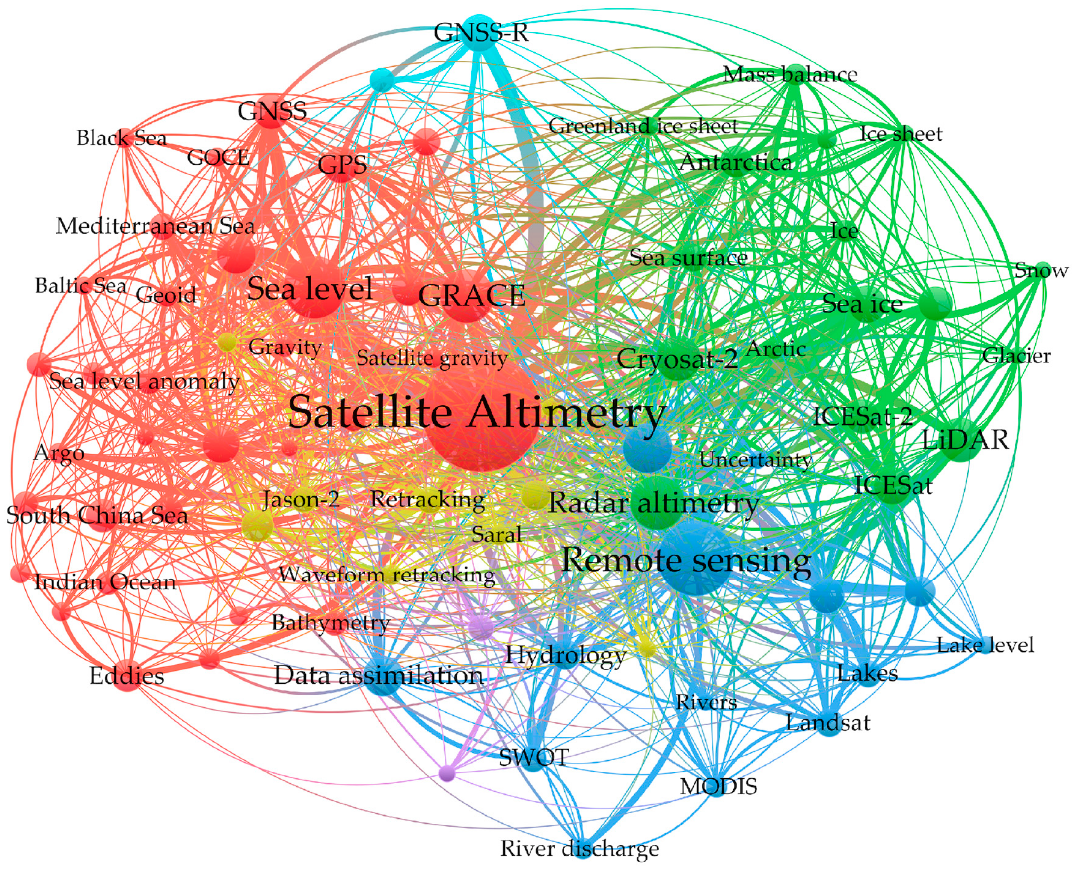
Figure 3. Semantic analysis of satellite altimetry and other disciplines and application fields.